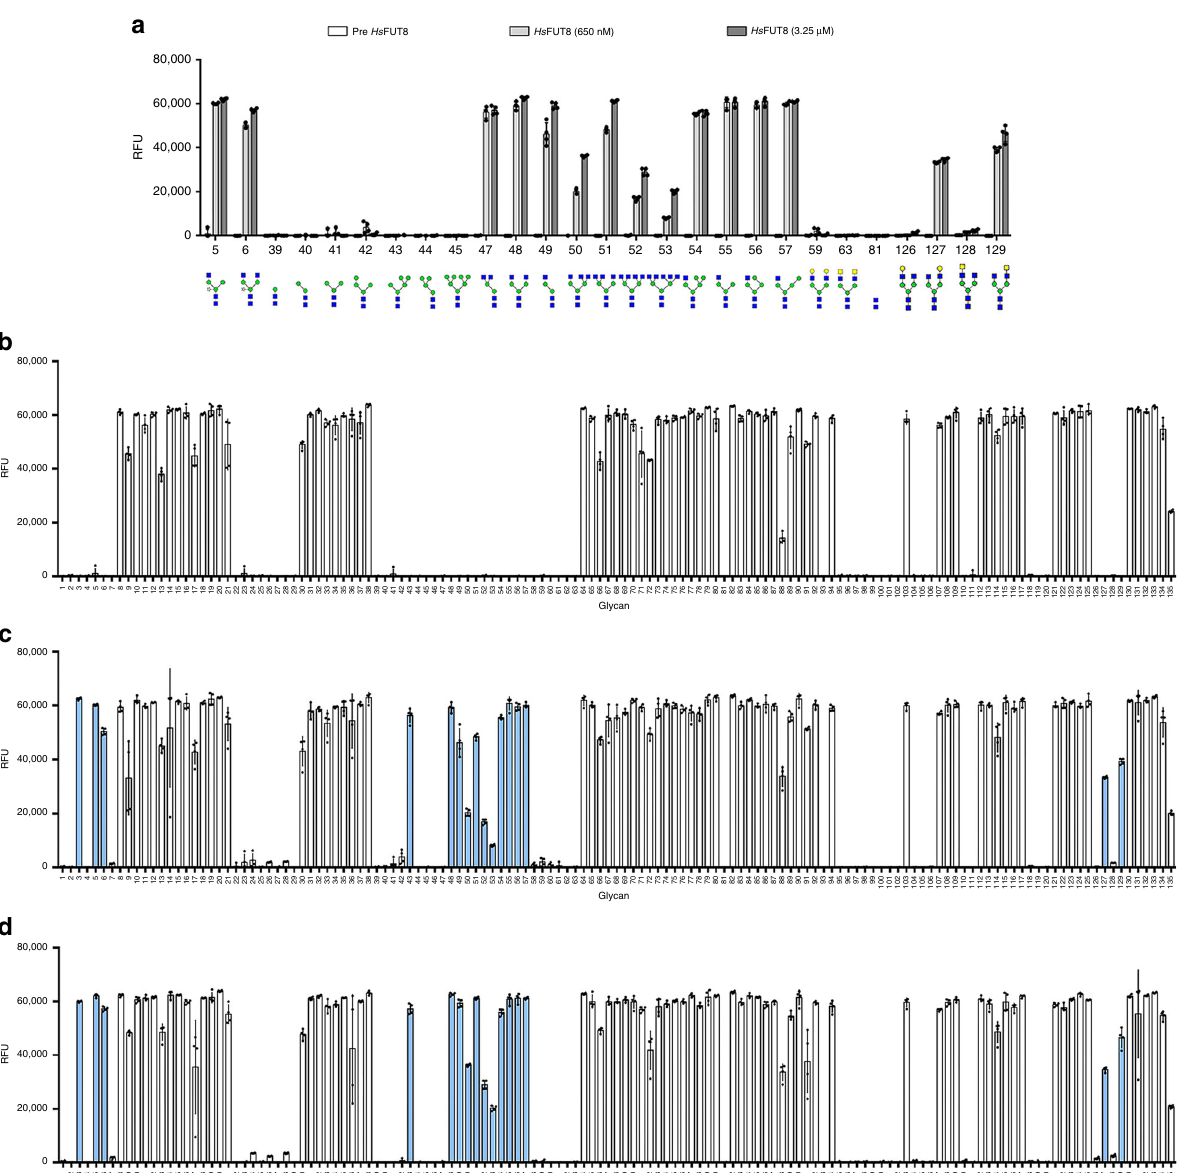
Fig. 2 Activity assay of Hs FUT8 on glycan microarray. a Aleuria aurantia lectin (AAL-555) binding before and after incubation with recombinant Hs FUT8 at two different concentrations (650 nM and 3.5 μ M) on a selection of glycan structures. b AAL-555-binding pro fi le on a full glycan array before treatment with recombinant Hs FUT8. c AAL-555-binding assay after treatment with recombinant Hs FUT8 at 650 nM enzyme concentration and d AAL-555-binding assay after treatment with recombinant Hs FUT8 at 3.25 μ M enzyme concentration. Histogram bars show the average fl uorescence RFU (relative fl uorescence units) values for four replicate spots on the array. Error bars represent the standard deviation of the average RFU values on the same microarray. N -glycans that show binding towards AAL after incubation with Hs FUT8 are highlighted in